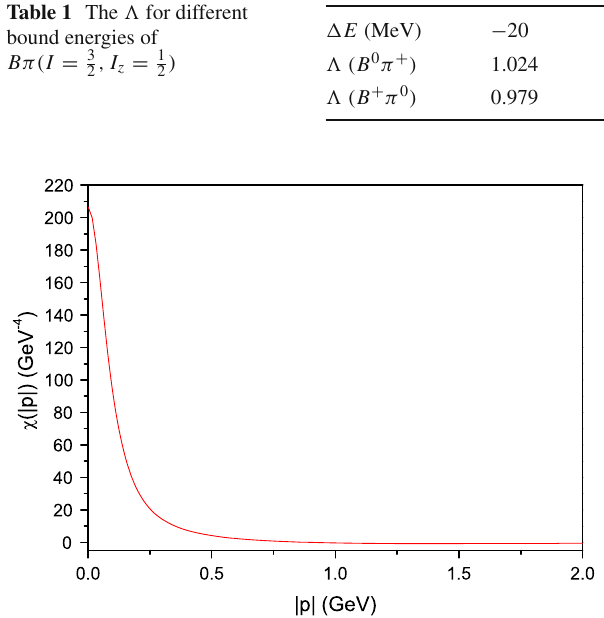
Fig. 3 The B–S wave function of the molecular state of B 0 π + ( (cid:18) E = 40 MeV)